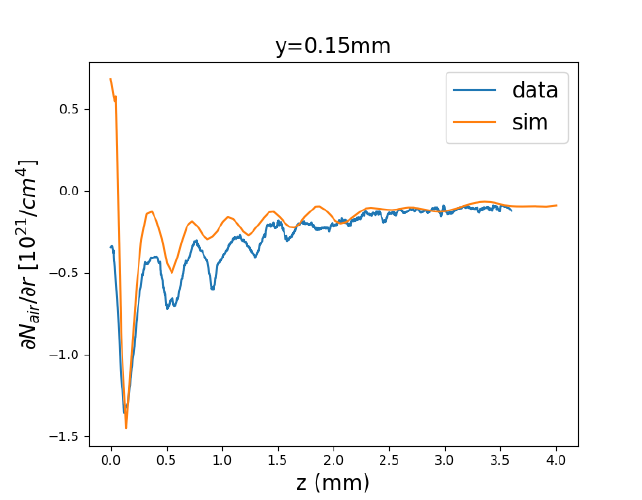
Figure 11. The line profile of ∂ n / ∂ y as a function of the vertical position z . The data successfully captured the positions of the first few shock